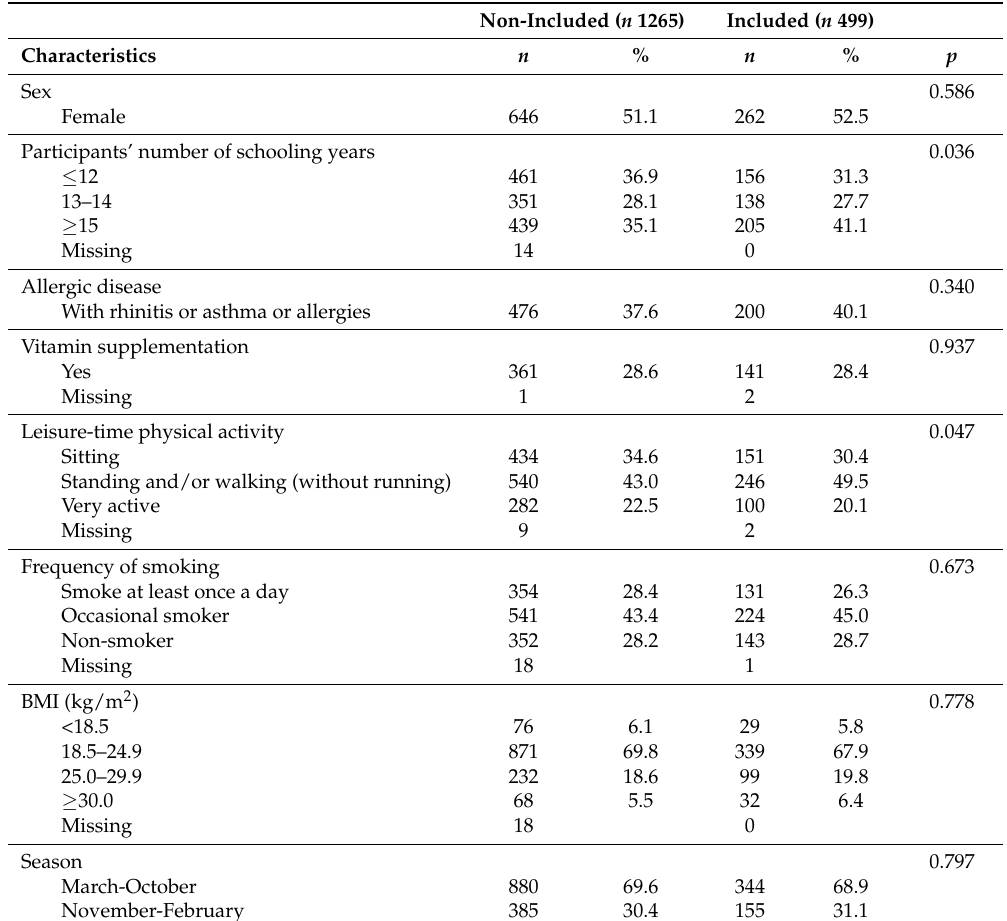
Table 1. Description and comparison of the characteristics of non-included and included participants in the present